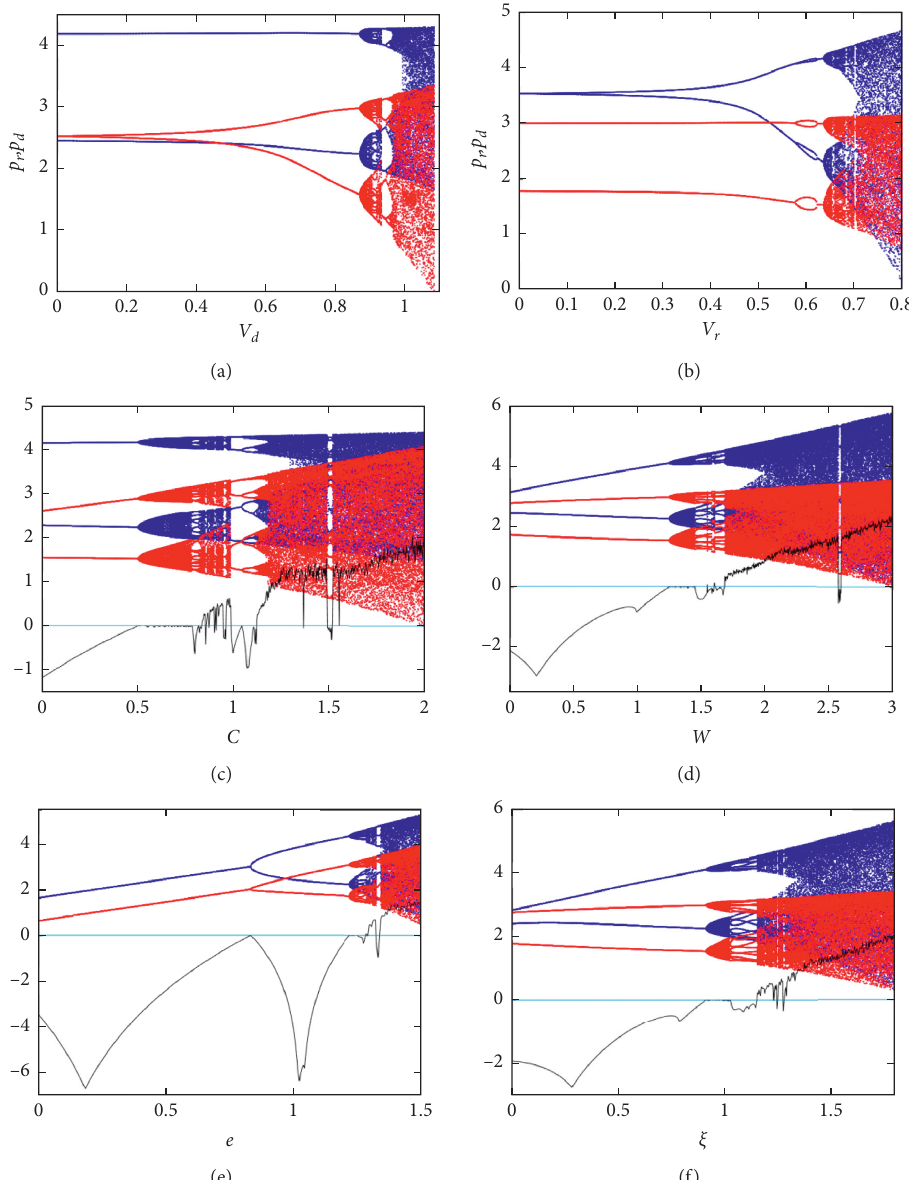
Figure 4: 1D bifurcation diagrams and maximum Lyapunov exponent diagrams of system (12) with fixed parameters are θ � 0 . 9037, β � 0 . 083, α � 0 . 4981, and c � 1 . 5192. (a) Taking v r as a bifurcation parameter, the other parameters are ξ � 0 . 9805, v d � 0 . 8967, e � 1 . 1555, c � 0 . 6784, and w � 1 . 3669. (b) Taking v c � 0 . 6784, and w � 1 . 3669. (c) Taking c as bifurcation parameter, the other parameters are v and w � 1 . 3669. (d) Taking w as a bifurcation parameter, the other parameters are v r � 0 . 6489, v d � 0 . 8967, ξ � 0 . 9805, e � 1 . 1555, and c � 0 . 6784. (e) Taking e as a bifurcation parameter, the other parameters are v c � 0 . 6784. (f) Taking ξ as a bifurcation parameter, the other parameters are v c � 0 .